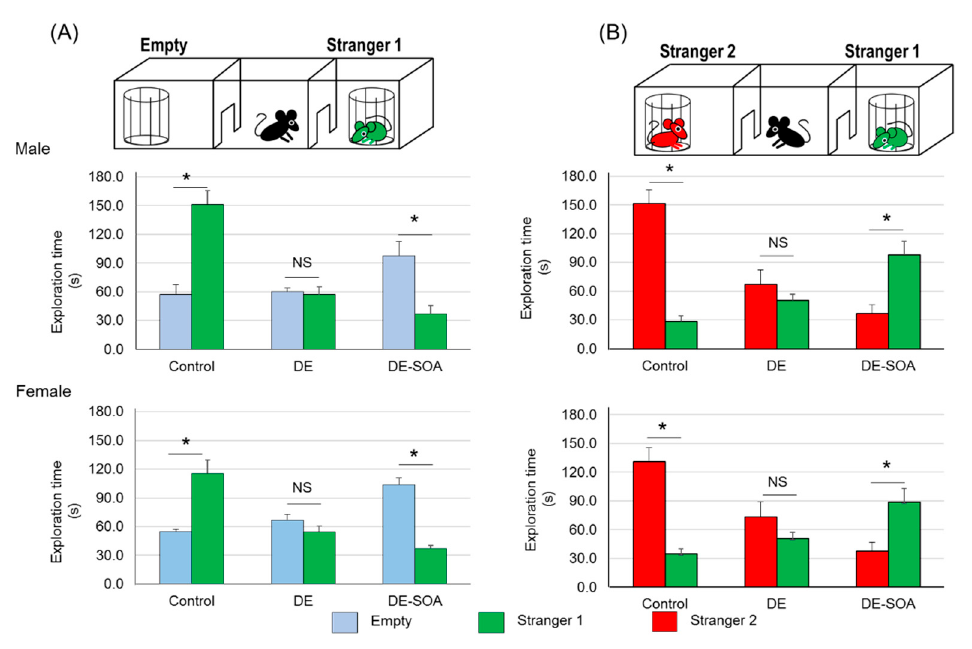
Figure 1. Assessment of social behavior using three ‐ chamber social behavior test. ( A ) sociability test and ( B ) social novelty preference test in the control and in the diesel exhaust (DE) ‐ and secondary organic aerosol (DE ‐ SOA) ‐ exposed male and female rats ( n = 16, * p < 0.05). NS: not significant.